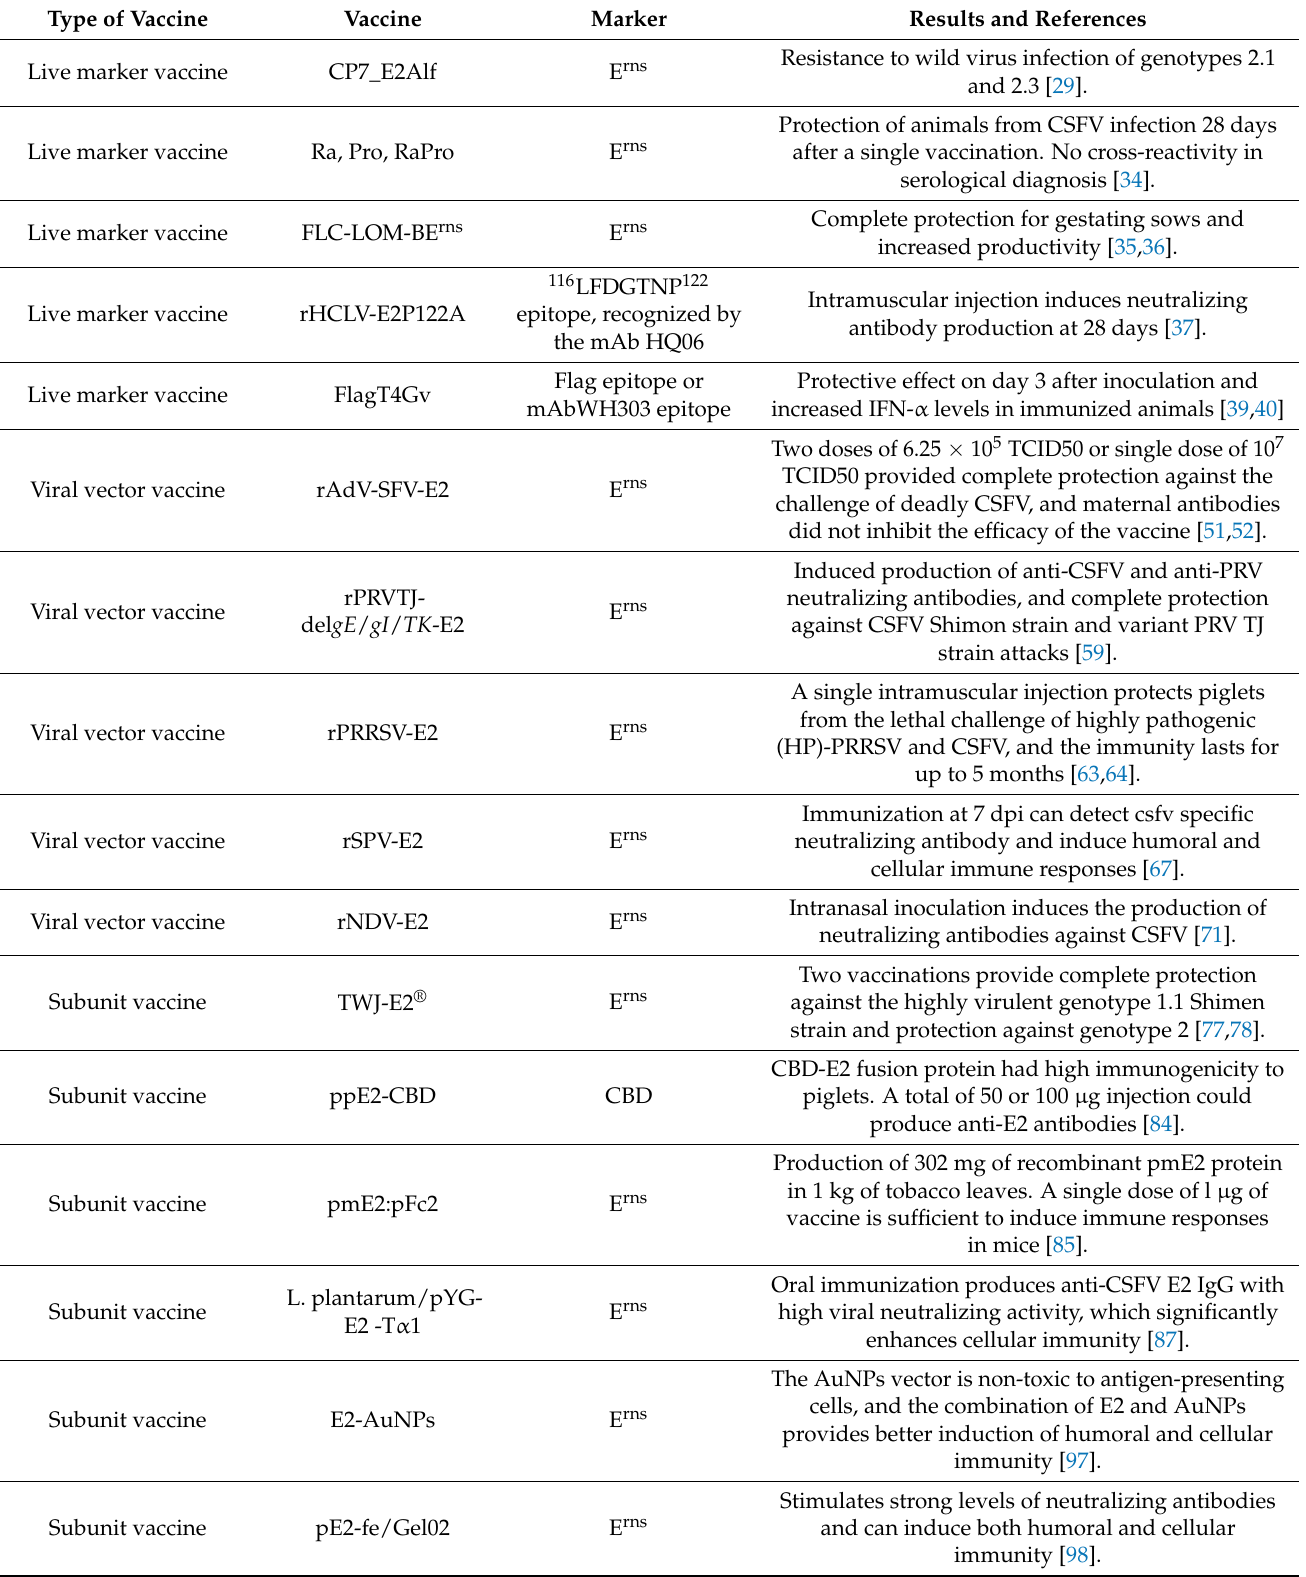
Table 1. A review of marker vaccines against CSFV published in the last few